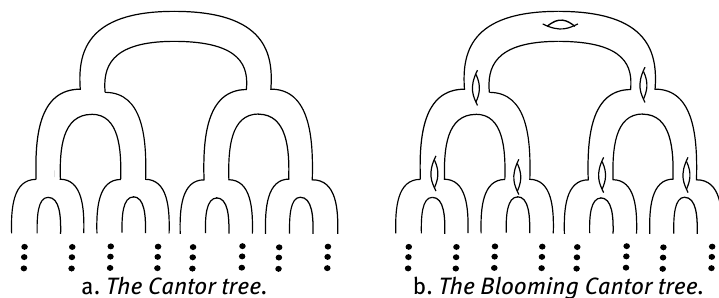
Figure 2: Surfaces whose ends spaces are homeomorphic to the Cantor